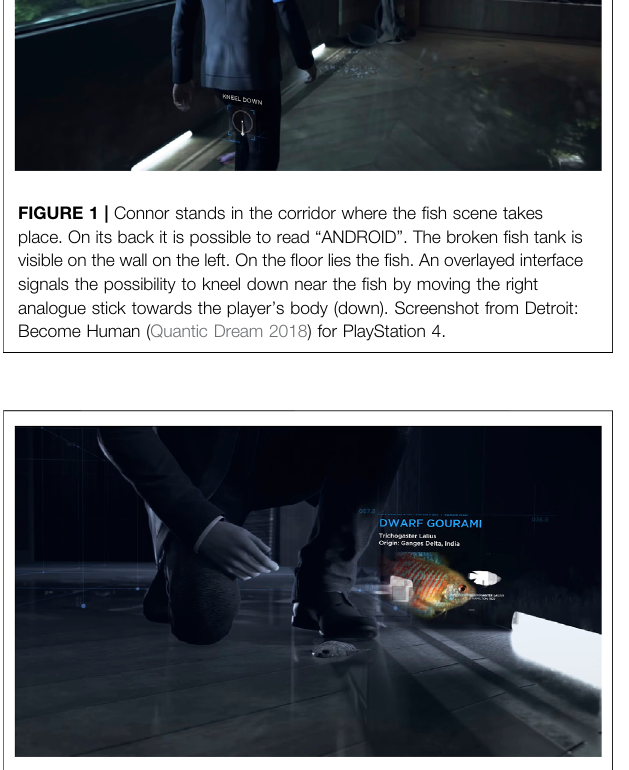
FIGURE 2 | Connor ’ s computational unit shows information about the fi sh in an overlayed interface. Both text and still images are visible. Screenshot from Detroit: Become Human (Quantic Dream 2018) for PlayStation